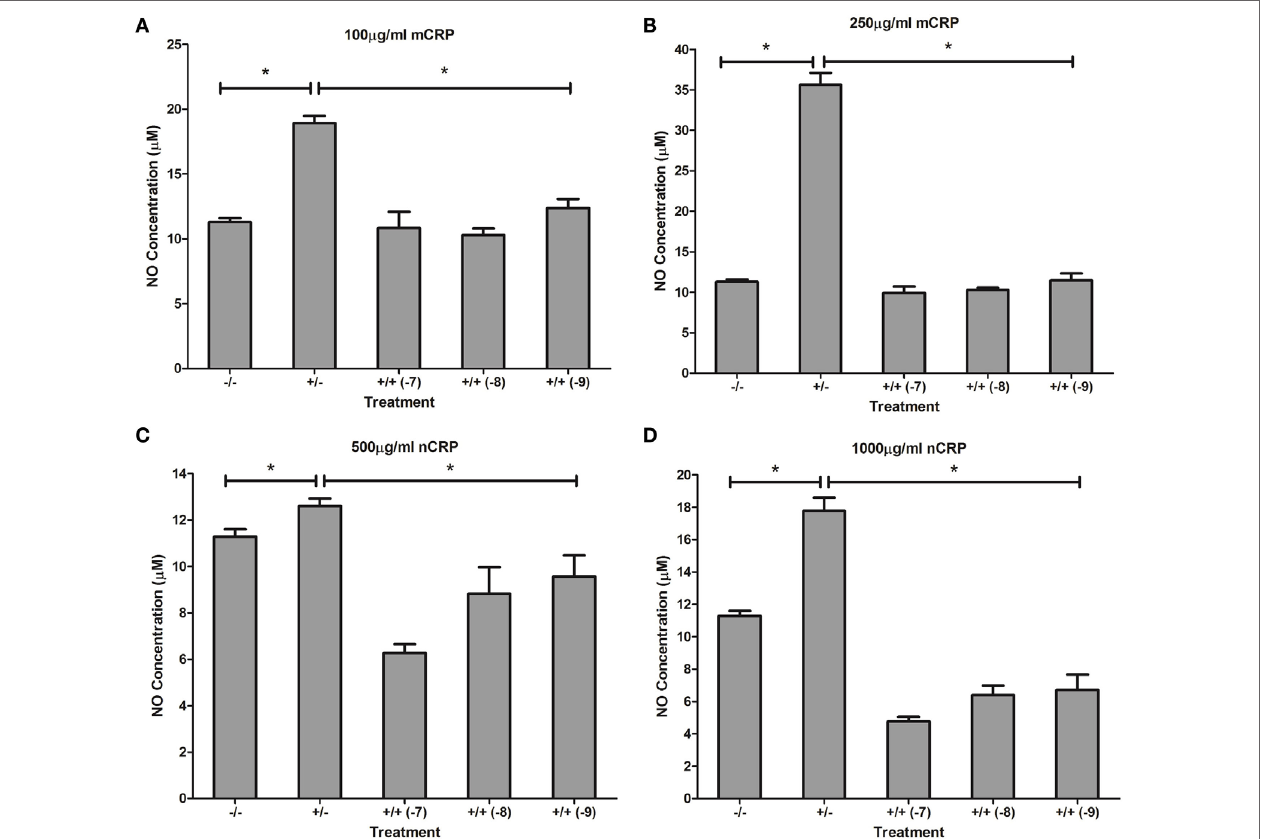
FigUre 7 | Effect of estrogen on C-reactive protein (CRP)-mediated nitric oxide (NO) production by unactivated U937 monocytes. Estrogen reversed CRP-induced NO production by unactivated U937 monocytes (a–D) . − / − represents the untreated negative control with no CRP or estrogen supplementation. + / − represents treatment with CRP alone. + / + represents treatment with both CRP and estrogen. The number in parentheses indicates the concentration (1 × 10 − 7 , 1 × 10 − 8 , or 1 × 10 − 9 M) of estrogen. *Denotes a significant ( P < 0.05; n = 12) difference in NO production following treatment with CRP or co-supplementation with estrogen. Errors bars represent the